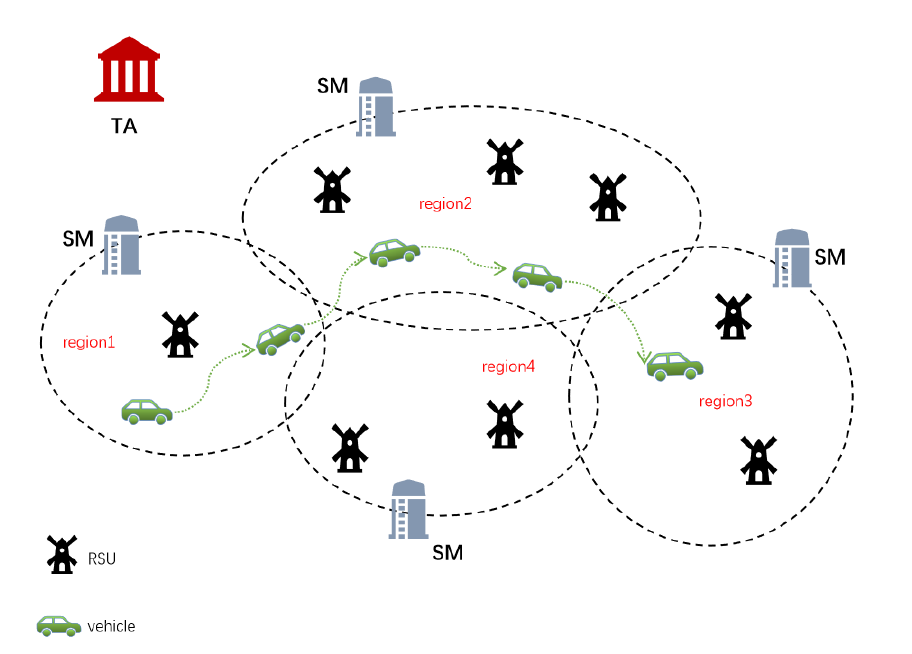
Figure 3. System